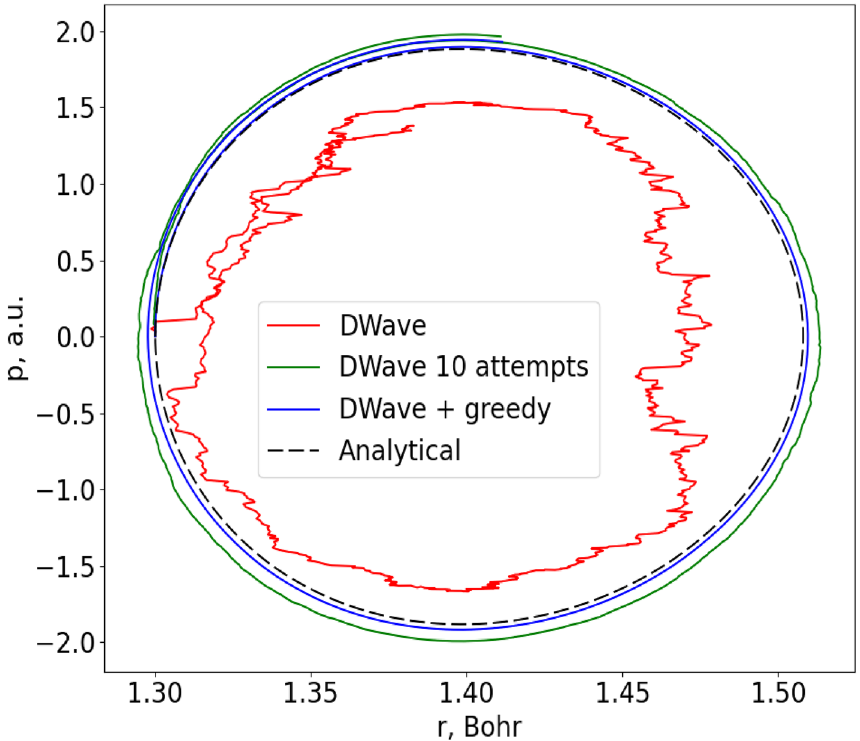
Figure 2. Trajectory for the vibration of the H 2 molecule in the low-energy regime of nearly harmonic motion. The trajectory is plotted in the phase space (momentum vs. coordinate). The points are connected in the order of time and start from r 0 = 1.3 Bohr with p 0 = 0 . The exact analytical solution (dashed black) and three solutions obtained on a quantum annealer (color lines) are